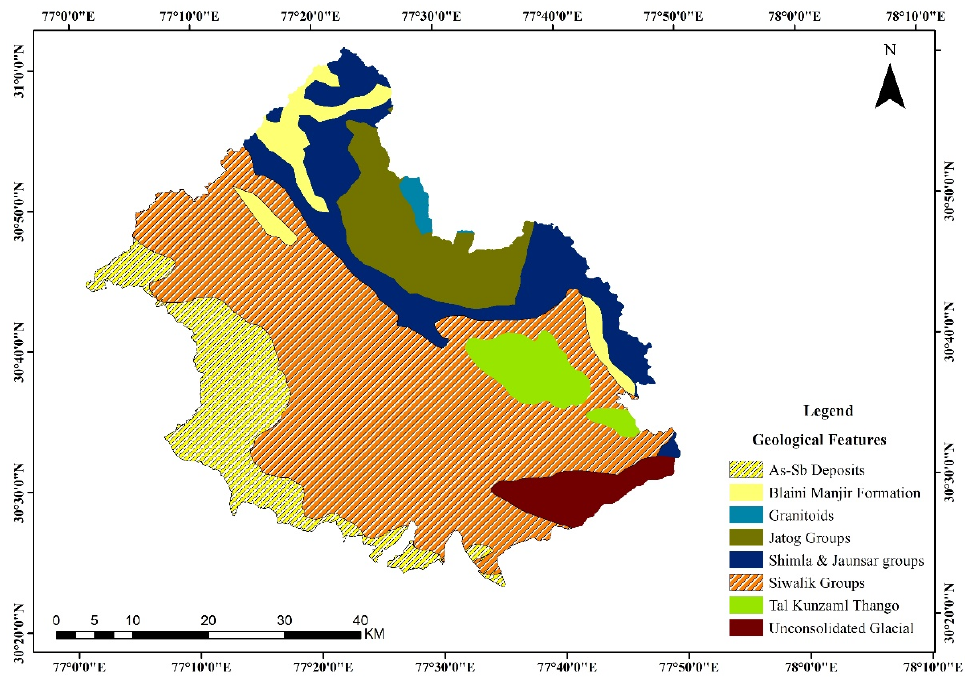
Figure 13. Geology map.